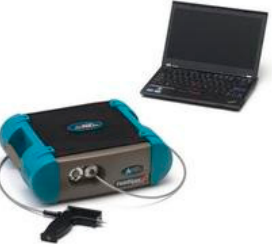
Figure 5. ASD FieldSpec4 Standard-Res. Table 4. Characteristics of the